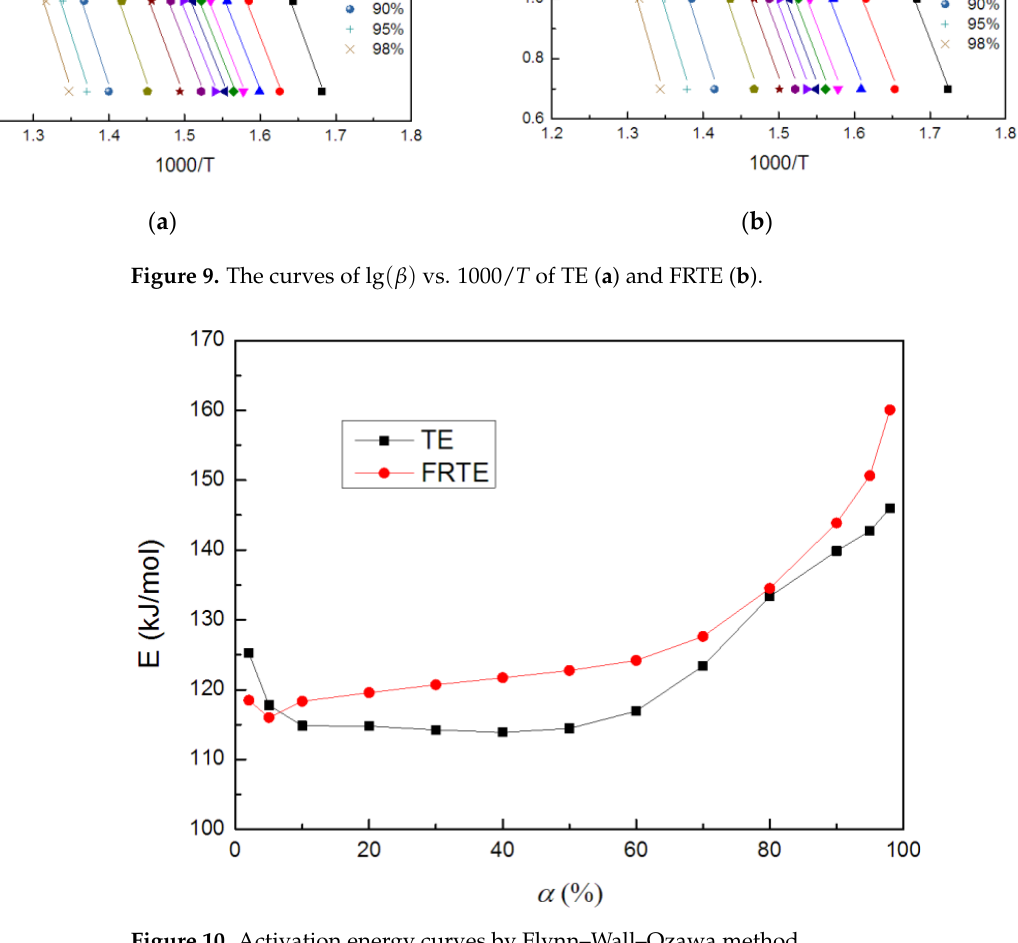
Figure 10. Activation energy curves by Flynn – Wall – Ozawa method.